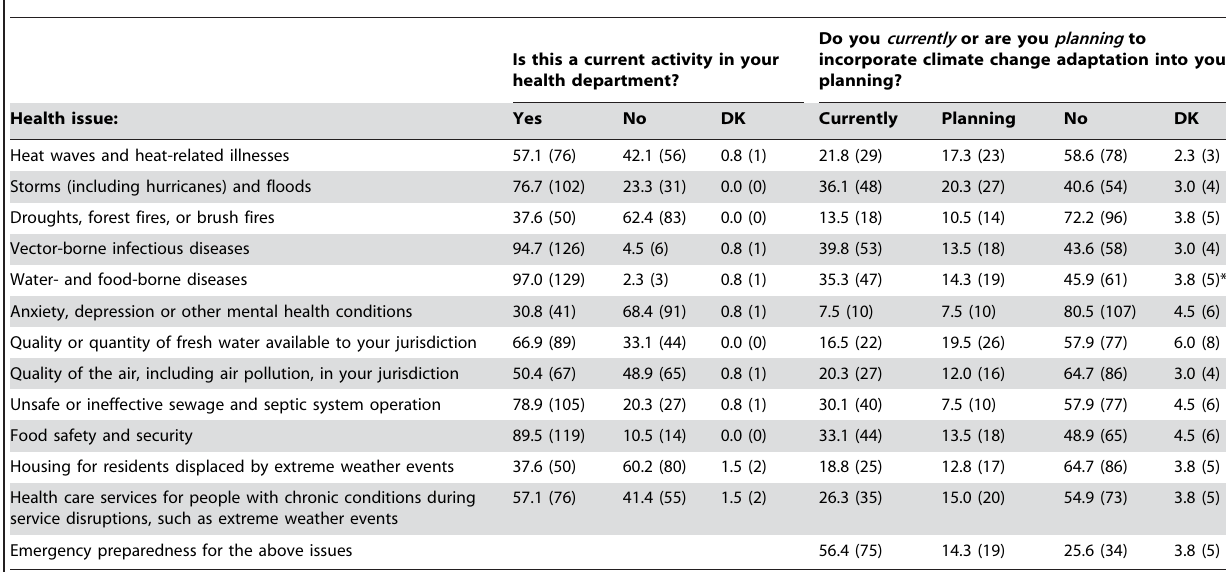
Table 5. Climate change adaptation activities of local health